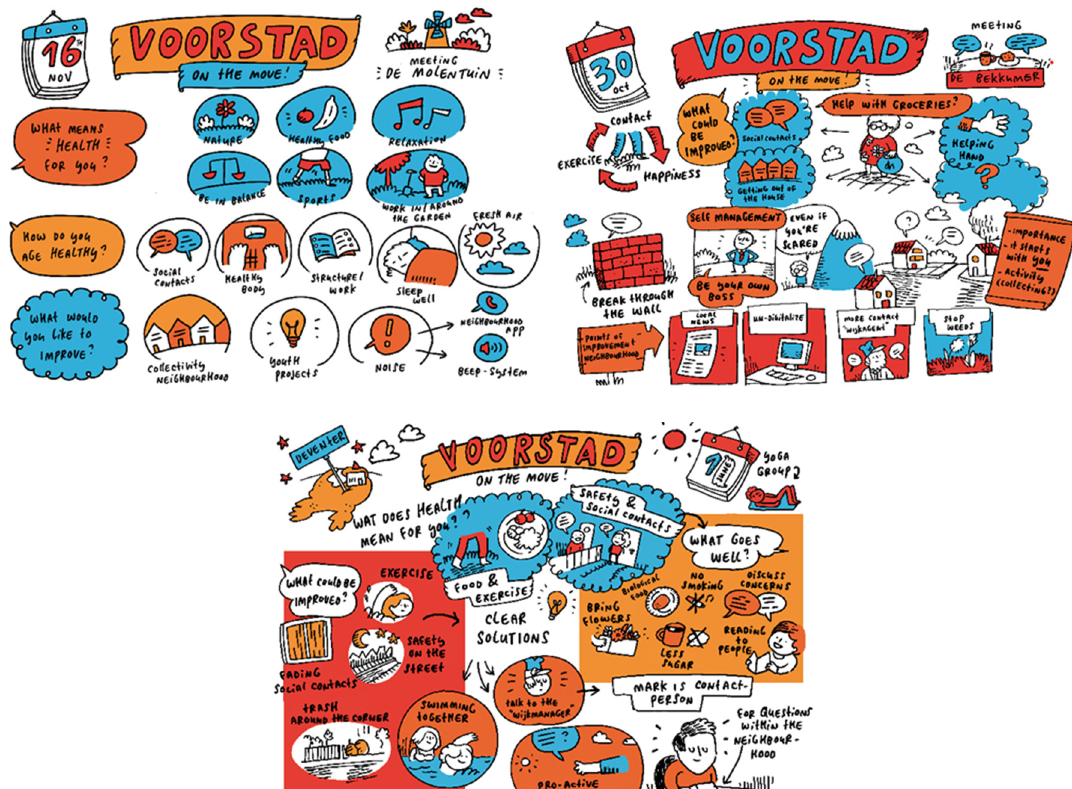
Figure 2. Visualization of the action plans of three different groups.